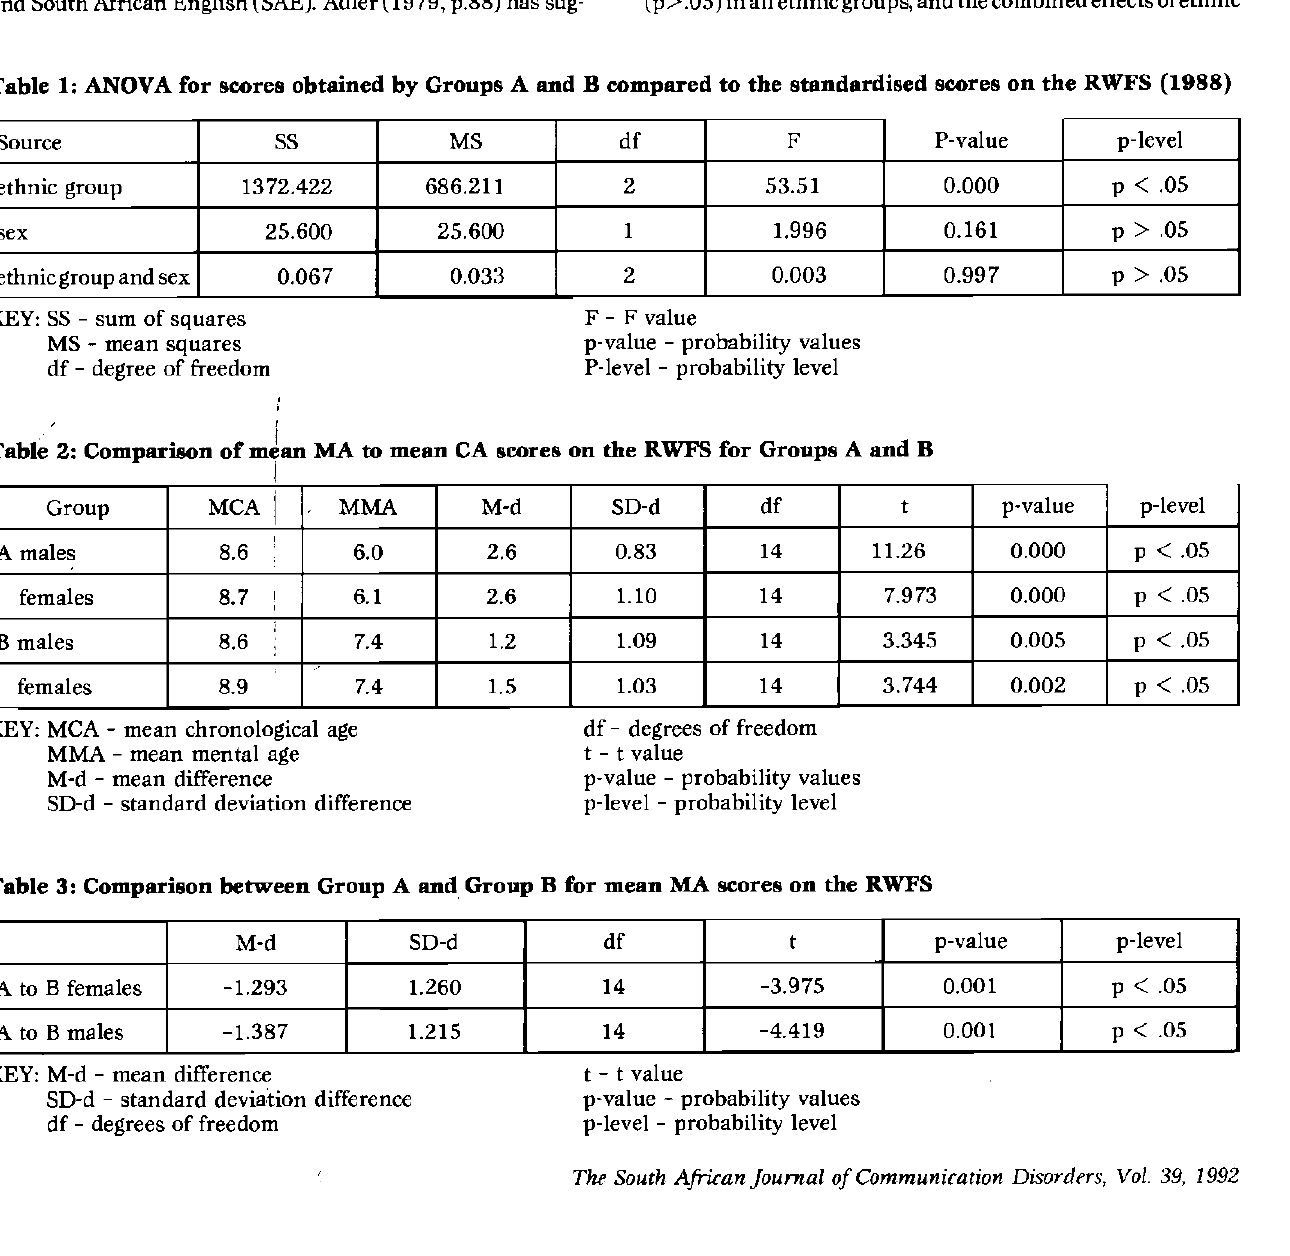
Table 1: ANOVA for scores obtained by Groups A and Β compared to the standardised scores on the RWFS (1988) Source